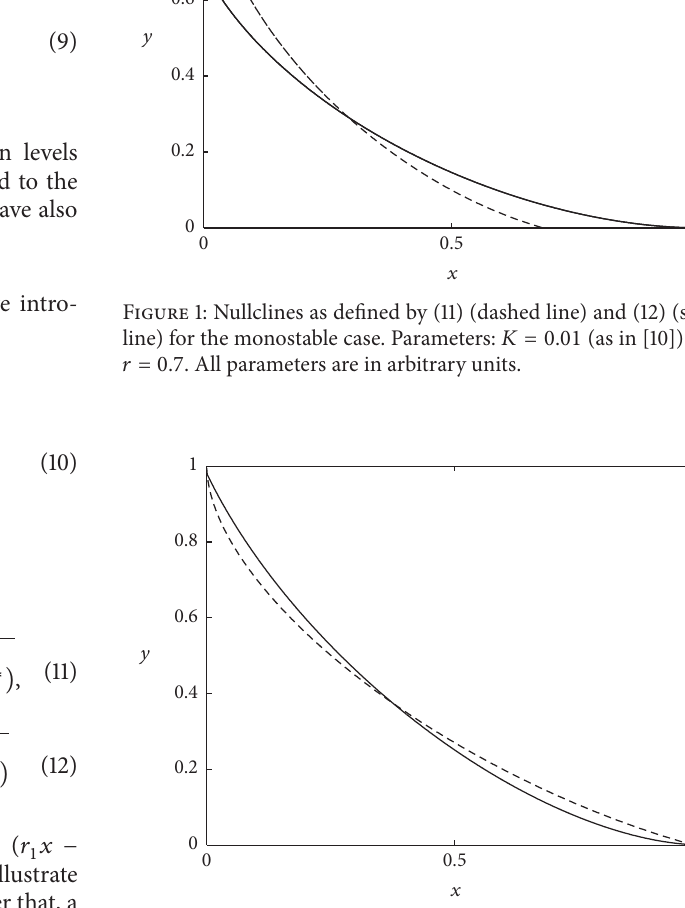
Figure 2: It is as in Figure 1 but for the bistable case. Parameters: 𝐾 = 0.01 and 𝑟 = 1.5